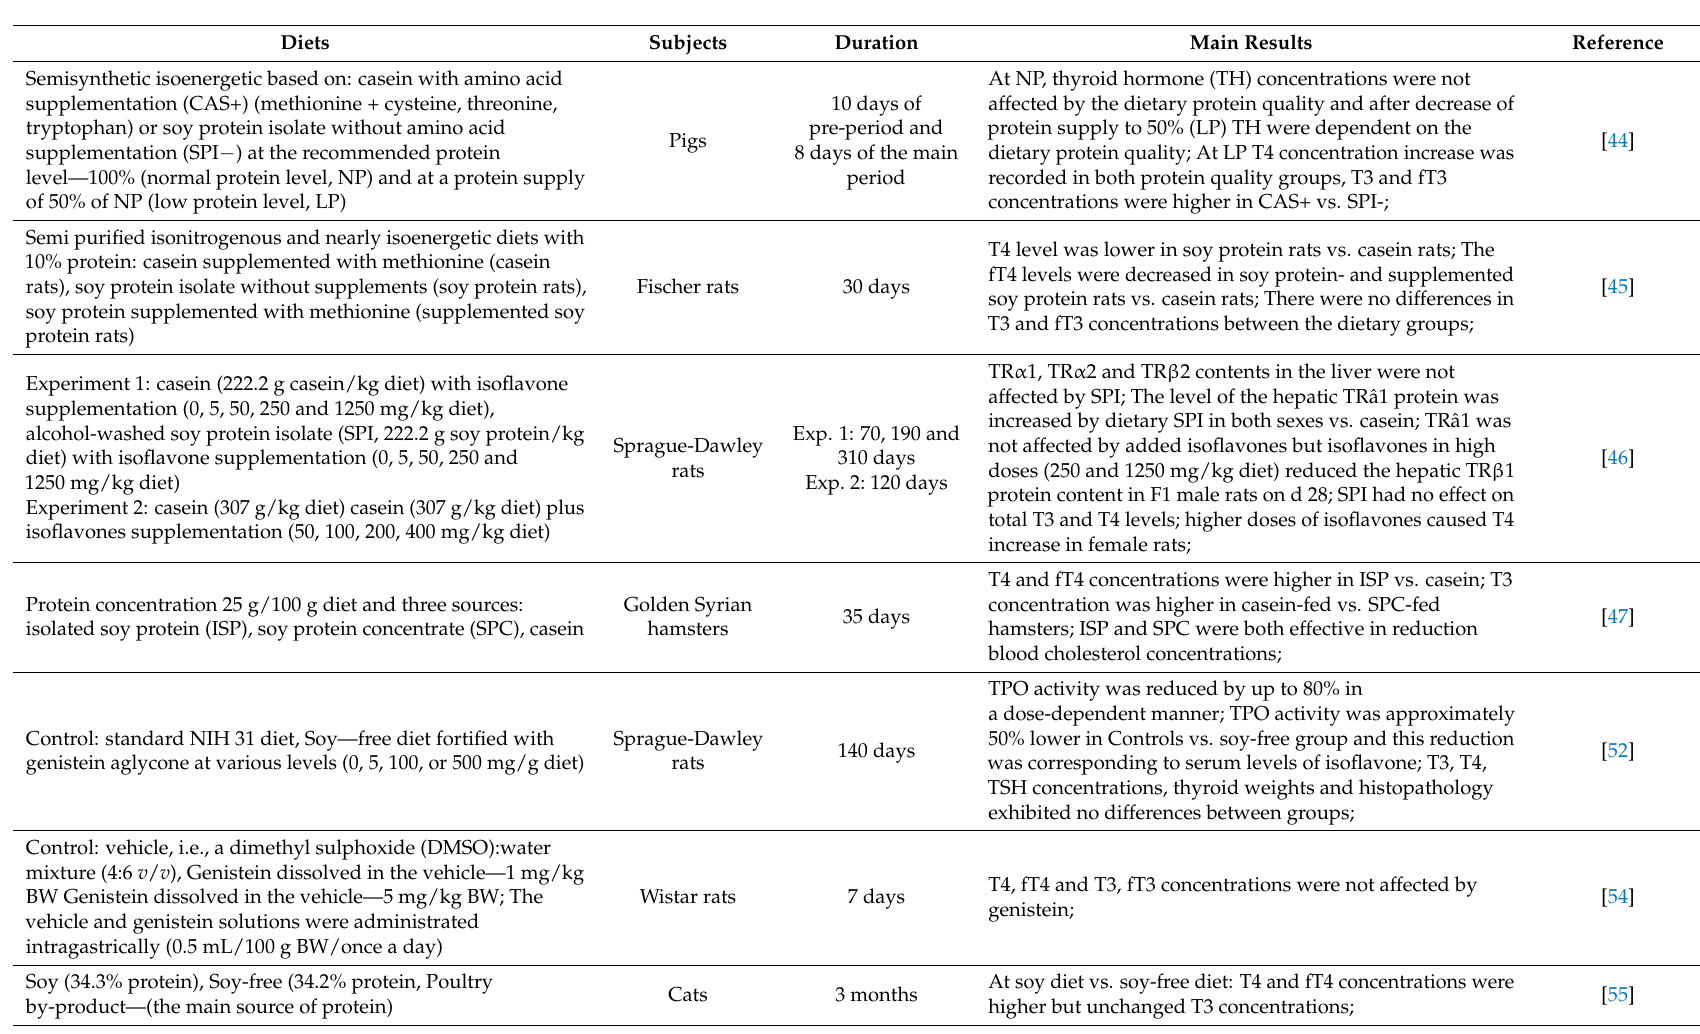
Table 2. Summary of selected studies investigating the effect of protein quality on HPT axis activity. Diets Subjects Duration Main Results